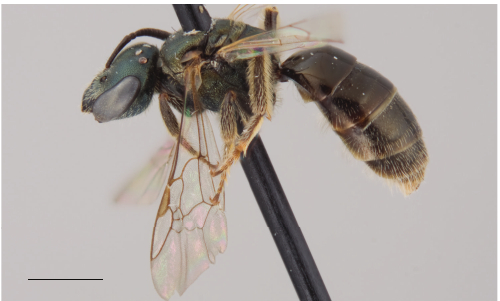
Figure 2: Lateral habitus of Lasioglossum (Dialictus) anomalum with three submarginal cells. Bar = 1mm.